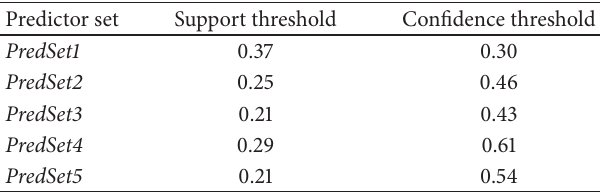
Table 12: Threshold of support and confidence measures for associating obtained clusters with physical climatic events.